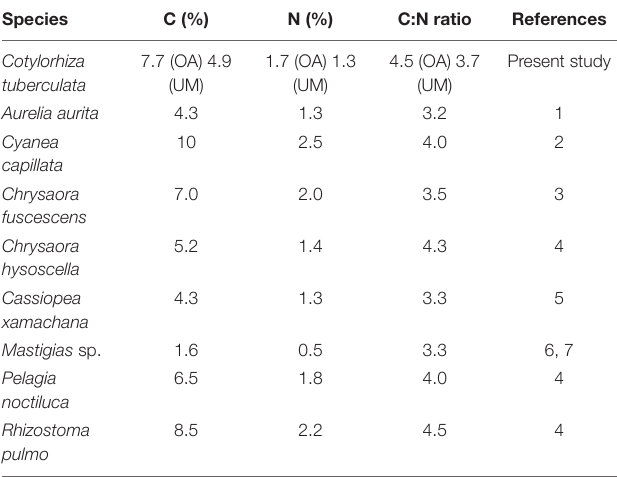
TABLE 2 | Comparison of the Symbiodiniaceae parameters of chlorophyll a concentration, cell density, and diameter of 4 symbiotic jellyfish: Cotylorhiza tuberculata, Cassiopea xamachana, Linuche unguiculata, and Mastigias sp. Species